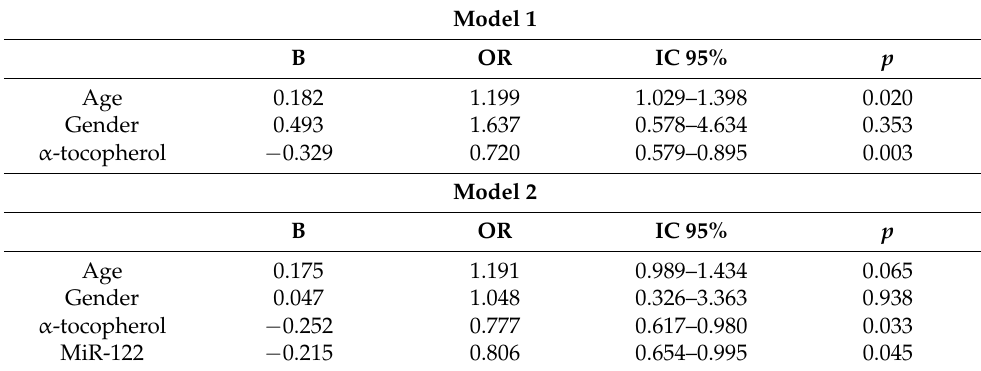
Table 3. Binary logistic regression analyses to assess whether α -tocopherol levels are associated with dementia, controlling for multiple confounding factors. Gender is indicated as M = 1 and F =